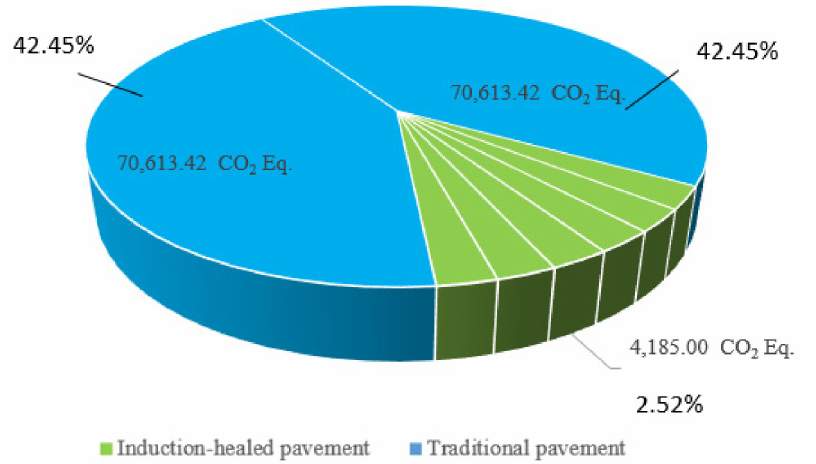
Figure 12. Greenhouse gas emission of two overhauls of traditional pavement and six electromagnetic induction maintenance sessions of induction-healed pavement.